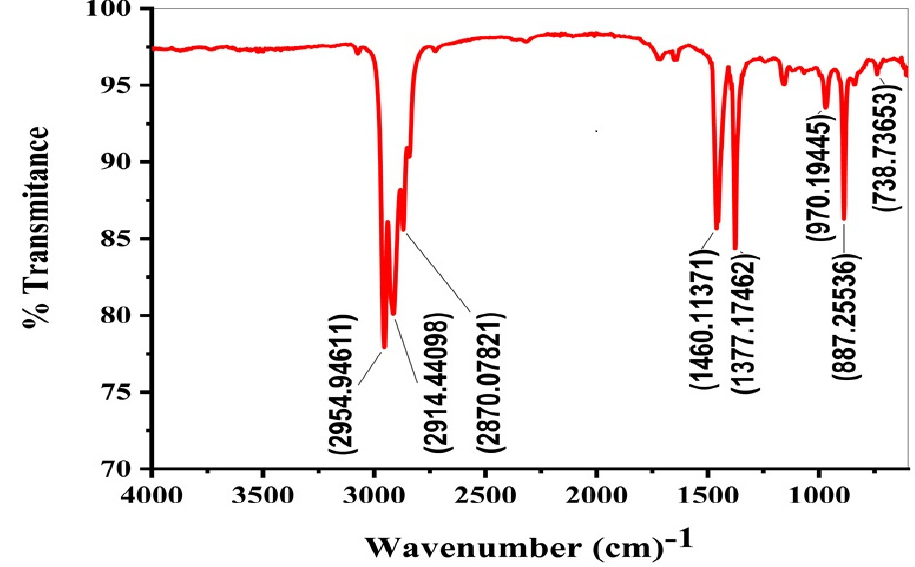
Figure 6. FTIR of oil recovered from the degradation of polypropylene waste.